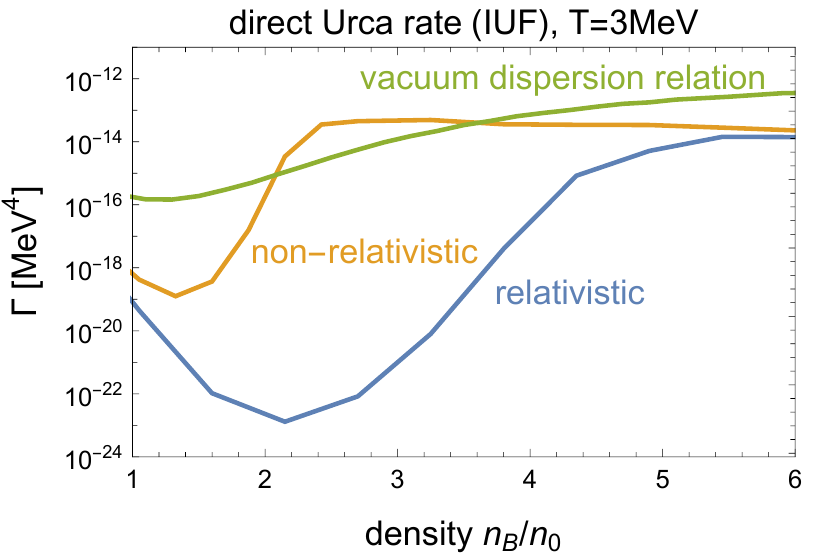
Figure 4. Direct Urca neutron decay rate calculated using relativistic, nonrelativistic and the vacuum dispersion relations at T = 3MeV for IUF.